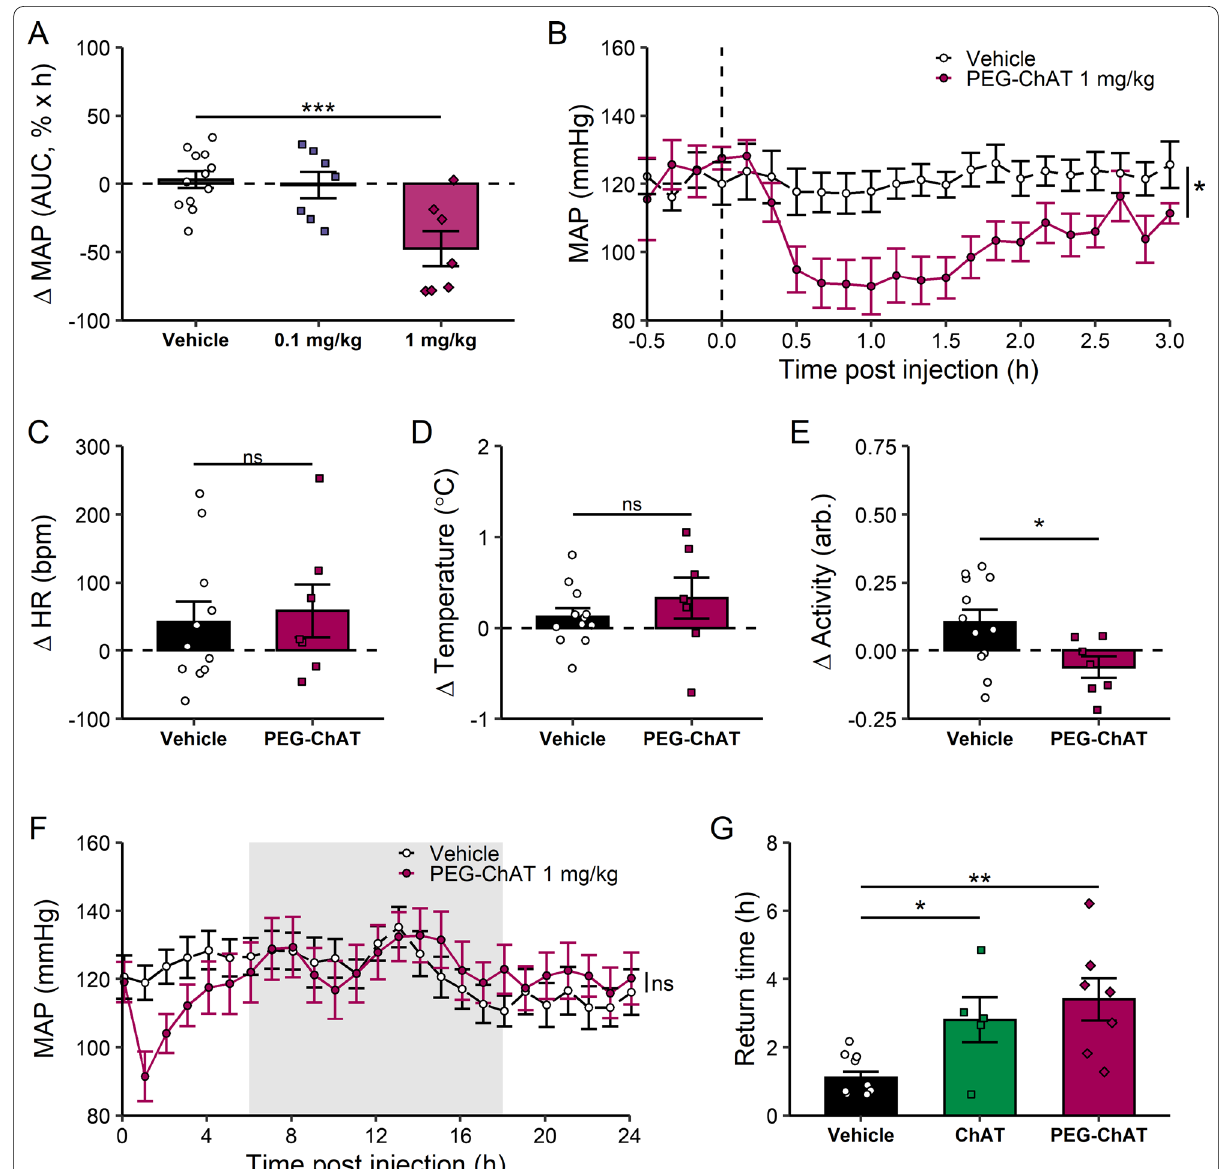
Fig. 4 PEGylation increases duration of ChAT‑induced blood pressure decrease. A change in normalized MAP. MAP is normalized to the 30‑min period before PEG‑ChAT or vehicle administration, and area under the curve is calculated from a baseline of 100% in the 3 h post‑PEG‑ChAT administration. Negative values correspond to decrease in MAP. n 7–11. ***p < 0.001, 1 mg/kg vs. vehicle. One‑way ANOVA with Dunnett’s = multiple comparison test. B MAP in 3 h post‑PEG‑ChAT administration. MAP was compared between PEG‑ChAT and vehicle groups at each time point post‑administration. n 7–11. *p < 0.05, two‑way ANOVA with Sidak’s multiple comparison test. C – E changes in C heart rate, D temperature = and E activity after PEG‑ChAT administration. Change is calculated as the baseline (30 min pre‑administration) subtracted from the average data in the 3 h post‑administration period. Data are represented as individual mouse data points, mean SEM. n 7–11. ns not significant, *p < 0.05, t‑test. ± = F MAP in the 24 h post‑PEG‑ChAT administration. Gray background indicates dark cycle. Data are averaged every hour and represented with lines as group mean SEM. n 7–11. ns: not significant, two‑way ANOVA with Sidak’s multiple comparison test. G time course responses to ChAT and ± = PEG‑ChAT. Baseline was defined as 30‑min average MAP prior to administration. Individual post‑administration MAP was normalized to individual pre‑administration MAP, and return time was calculated for each animal. Return time was defined as the minimum time after administration where mice returned to baseline MAP for a 10‑min average period. Data are represented as individual mouse points, with bars with mean SEM. n 5–11. ± = *p < 0.05, **p < 0.01, one‑way ANOVA with Dunnett’s multiple comparison